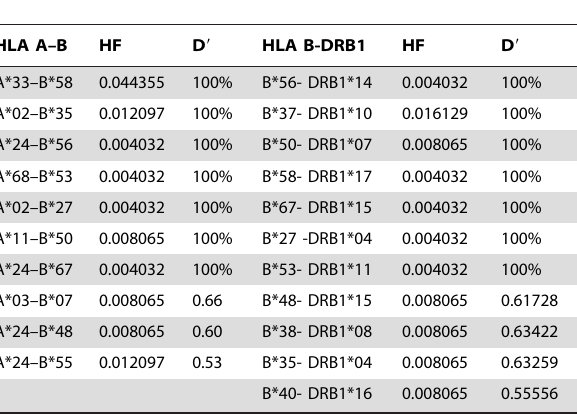
Table 4. Haplotype frequency and significant linkage disequilibrium parameter of HLA two-loci haplotypes in Tujia population of Wufang region,